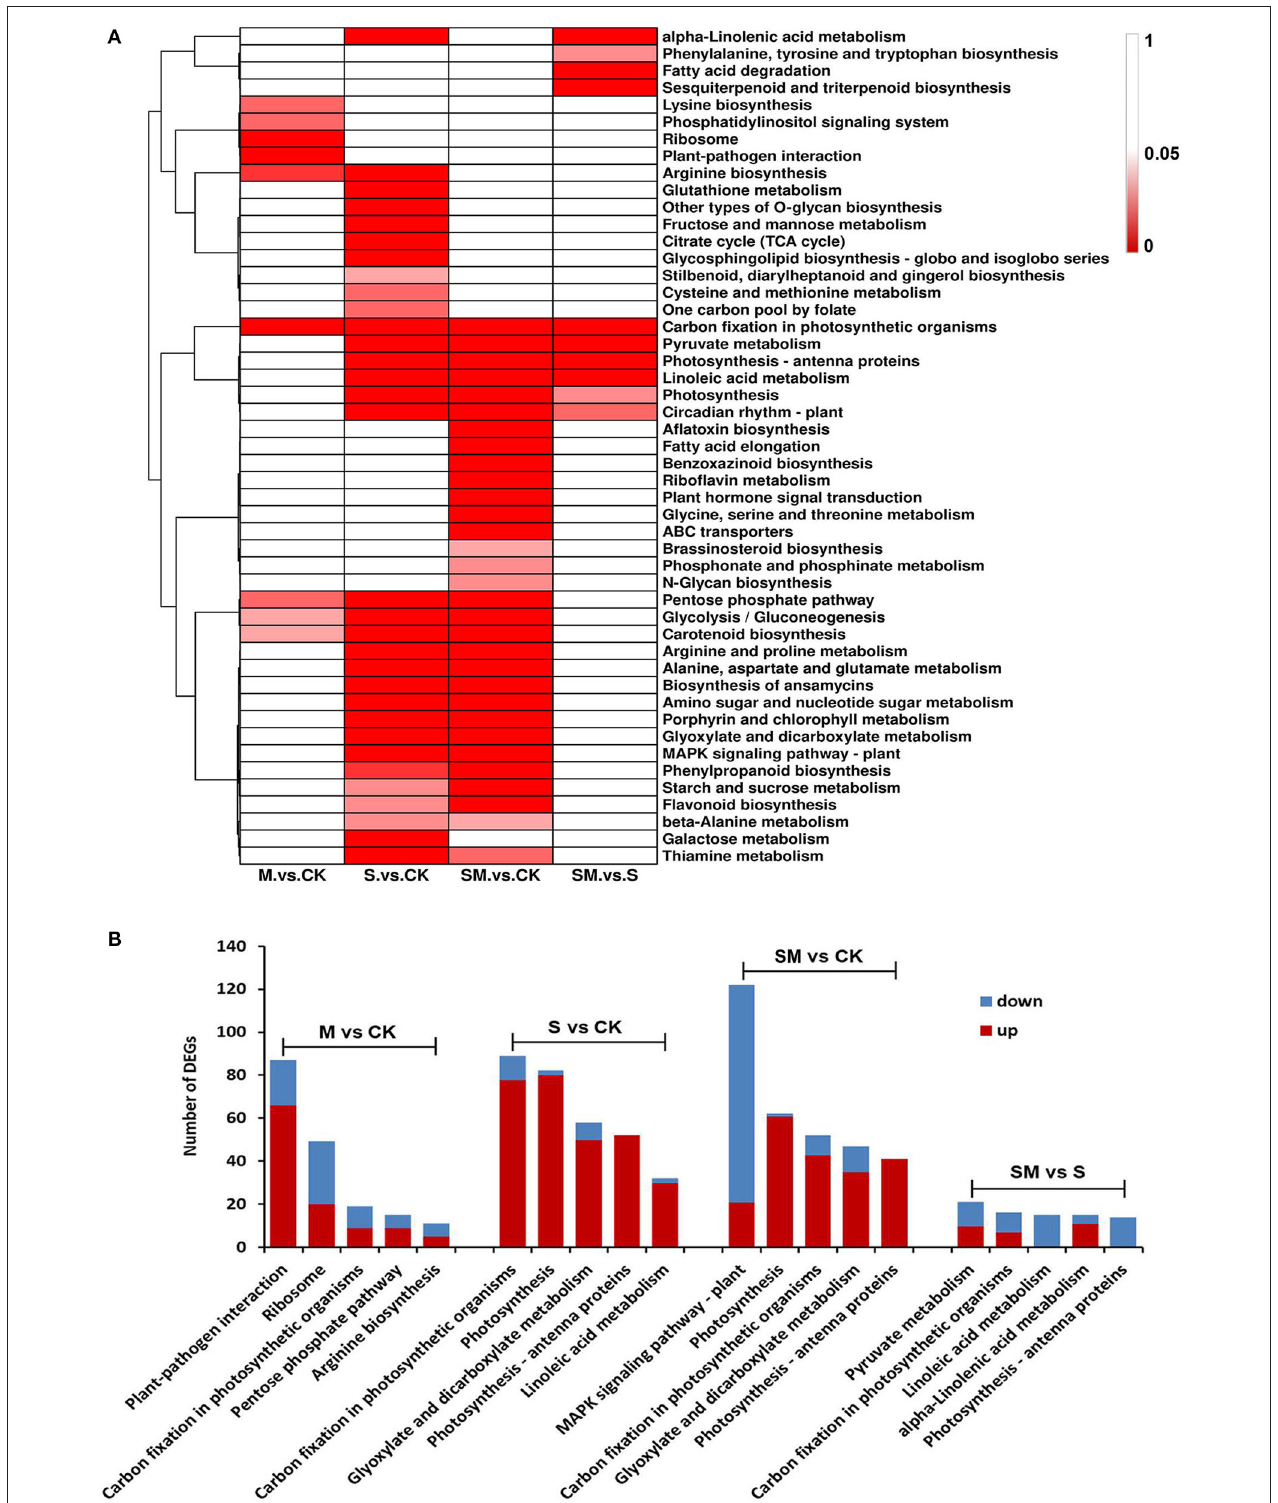
FIGURE 5 | KEGG pathway enrichment analysis of DEGs in different comparisons. (A) Heat map analysis of the significant p -values ( p < 0.05) of KEGG term in different comparisons. (B) Top-5 KEGG pathways of DEGs in different comparisons.